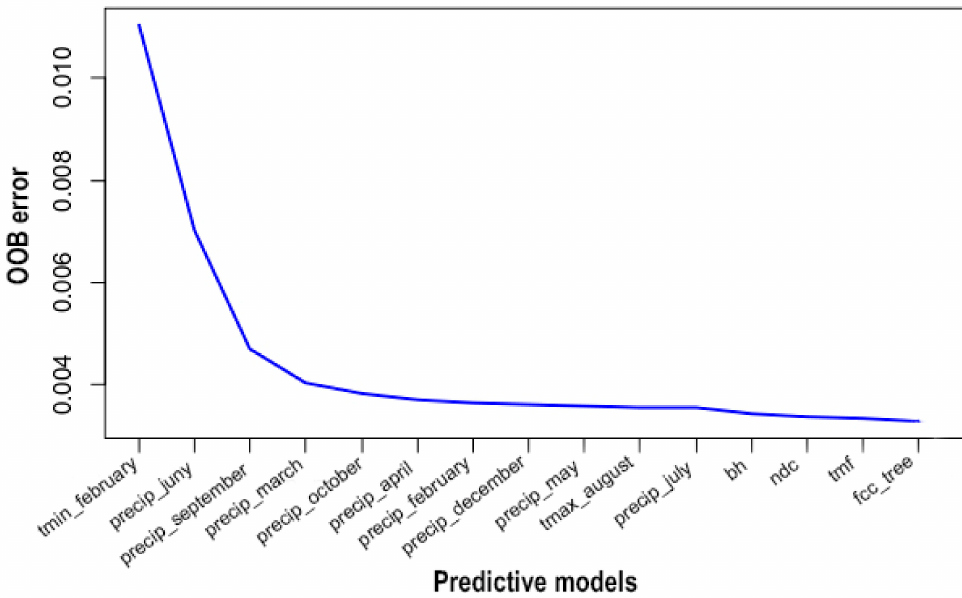
Figure 5. Importance of environmental predictors in predicting the presence or absence of defoliation of processionary moth in southeastern Andalusia (Spain). Importance is measured by Random Forest (variable descriptions: Table S4: Climate variables from REDIAM and GEE, Supplementary Material).